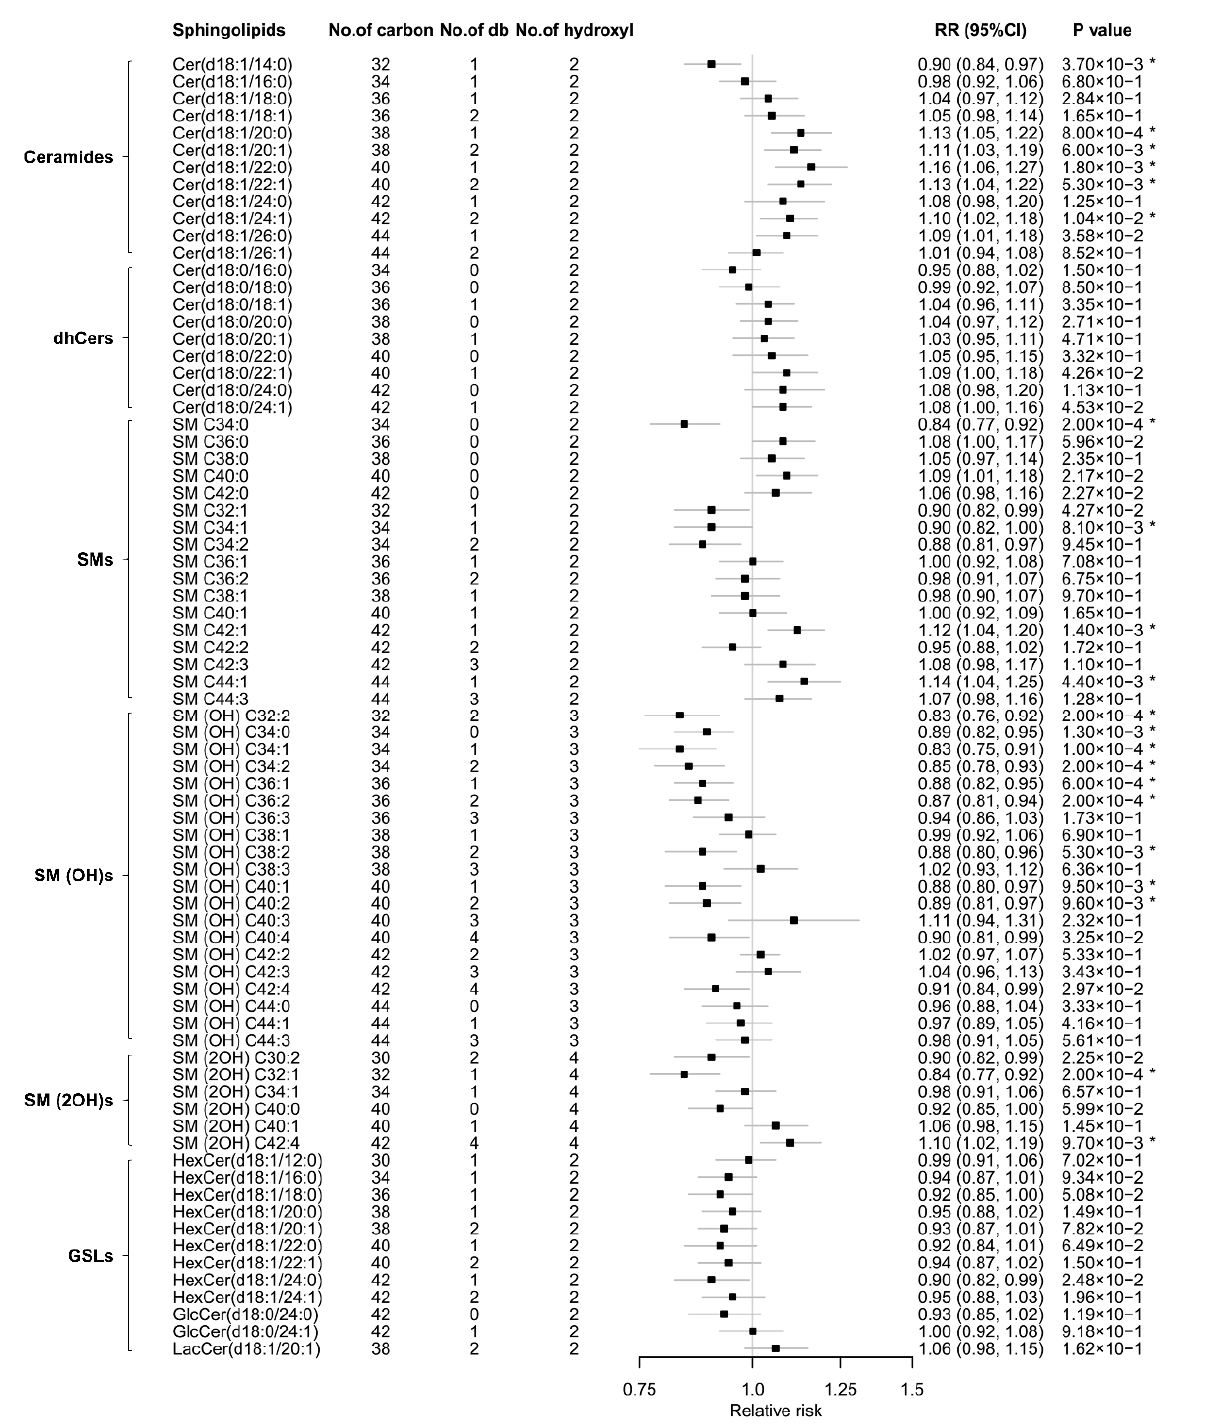
Figure 1. RRs (95% CIs) of individual sphingolipids with incident metabolic syndrome. Model was adjusted for age, sex, region (Beijing or Shanghai), residence (urban or rural), educational attainment (0–6 years, 7–9 years, or ≥ 10 years), current smoking (yes or no), current alcohol drinking (yes or no), physical activity (low, moderate, or high), family history of chronic diseases (yes or no), use of lipid-lowering medication (yes or no), and BMI. *, p < 0.05 after correction for multiple testing using the Benjamini–Hochberg method. Cer, ceramide; db, double-bound; dhCer, dihydroceramide; GlcCer, glucosylceramide; GSL, glycosphingolipid; HexCer, hexosylceramide; LacCer, lactosylceramide; No, number; RR, relative risk; SM, sphingomyelin; SM (OH), sphingomyelin with one additional hydroxyl; SM (2OH), sphingomyelin with two additional hydroxyls.